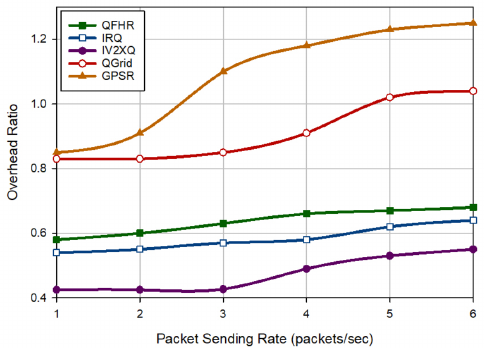
Figure 16. Routing overhead in different approaches based on PSR.